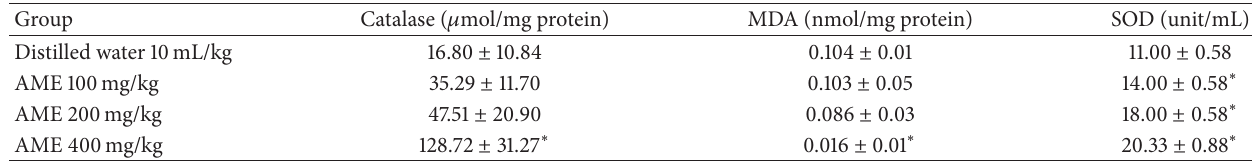
Table 2: The in vivo antioxidant effects of AME in rats (mean ±